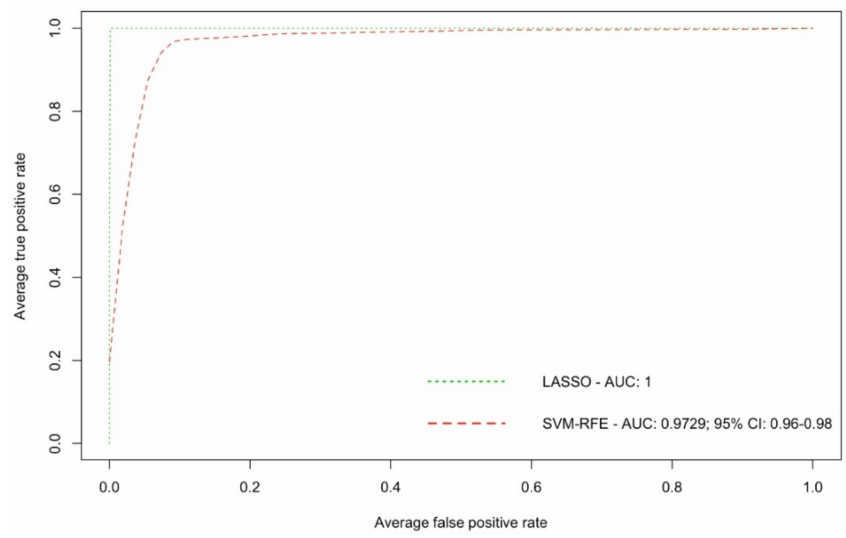
Figure 3. Receiver operating characteristics (ROC) curve with the area under the curve (AUC) showing the prediction performance of the 16 selected ions for all 55 samples.